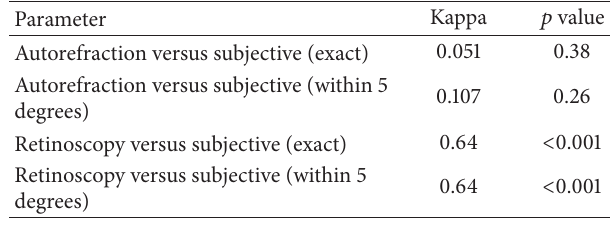
Table 4: Agreement between cylinder axis of subjective refraction and that of retinoscopy or autorefraction.